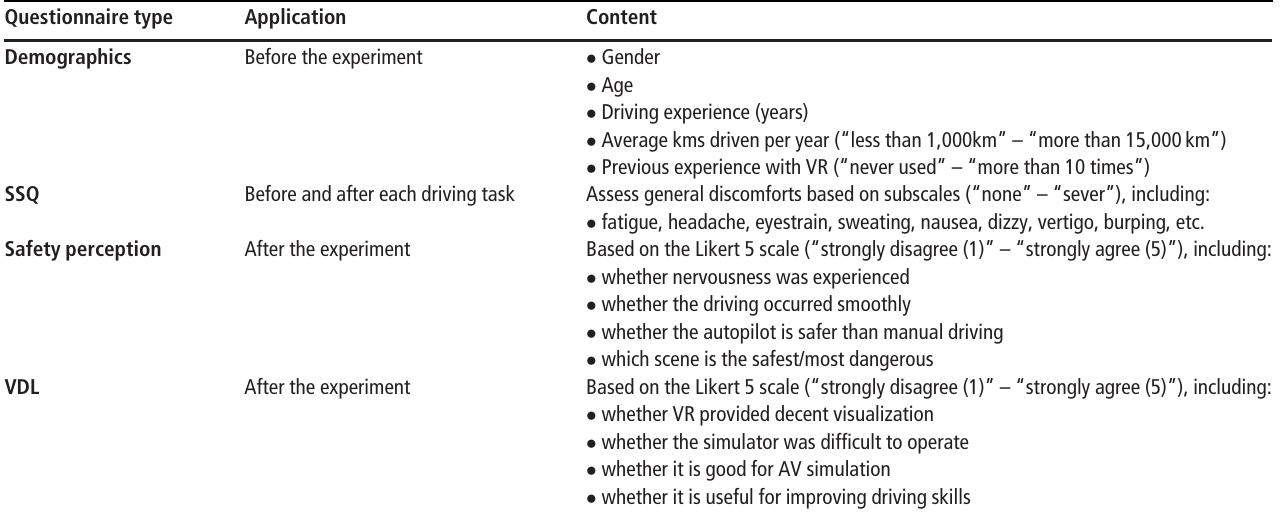
Table 2 Questionnaire content Questionnaire type